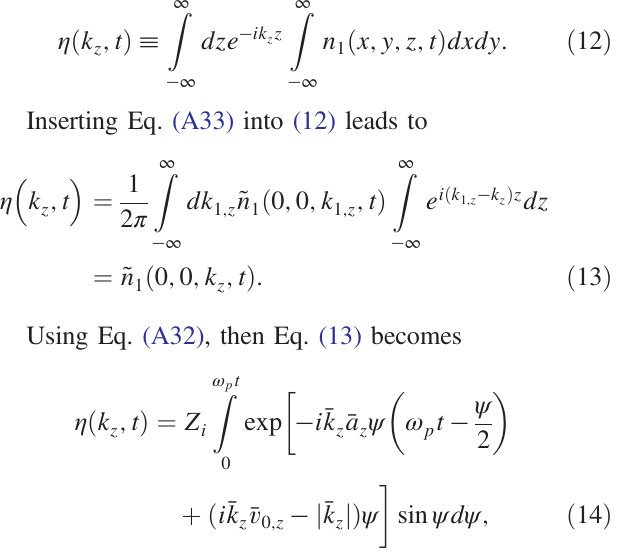
r , and the plots are taken at ω z z ; t Þ with respect to that of the zero-acceleration z